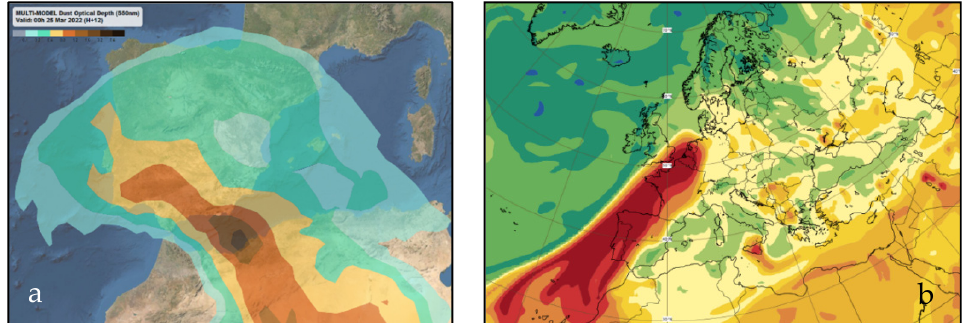
Figure 1. ( a ) Aerosol Optical Depth of 25 March 2022 [6] by MULTI-MODEL [8] illustrating the haze episode over the Iberian Peninsula. Dust image was provided by the WMO Barcelona Dust Regional Center and the partners of the Sand and Dust Storm Warning Advisory and Assessment System (SDS-WAS) for Northern Africa, the Middle East and Europe. ( b ) CAMS [9] forecast of the total column of sulphur dioxide initiated at 00 UTC on 19 October [7], indicative of ash flowing from La Palma eruption.